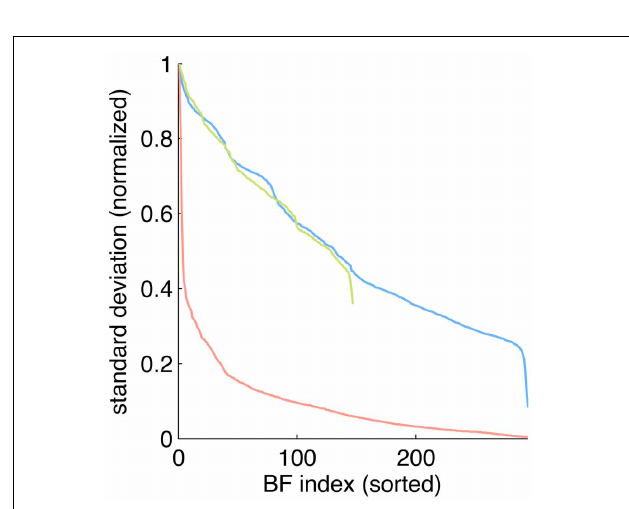
FIGURE 9 | Dispersal of different codes: ICA on preprocessed data (blue), PCA on preprocessed data (red) and ICA on LMS images (green). For each code, the mean of the per image response standard deviation normalized to the largest value is plotted for each basis function. Note that for unfiltered LMS images the dimensionality of the data is lower, yielding only 147 basis